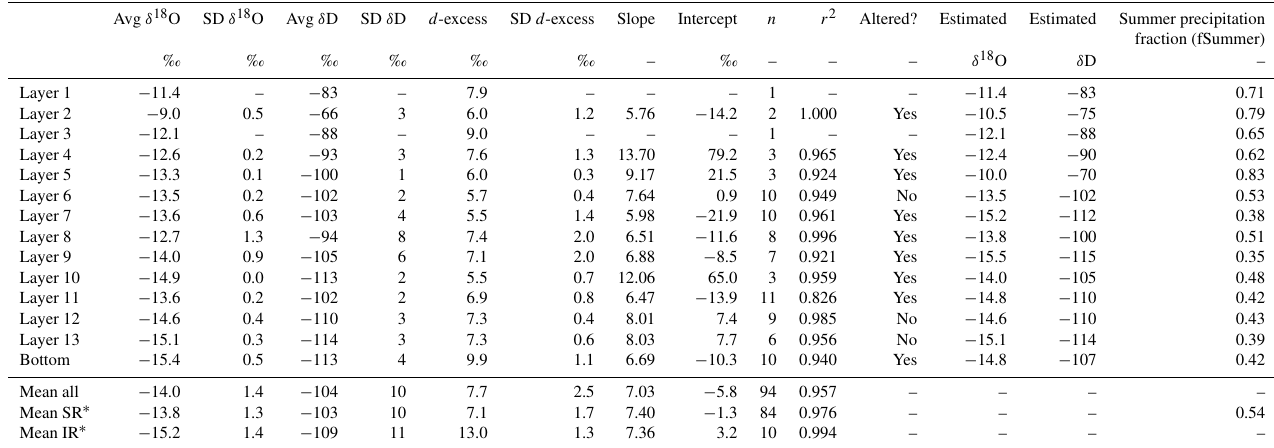
Table 2. Stable-isotope results for Winter Wonderland